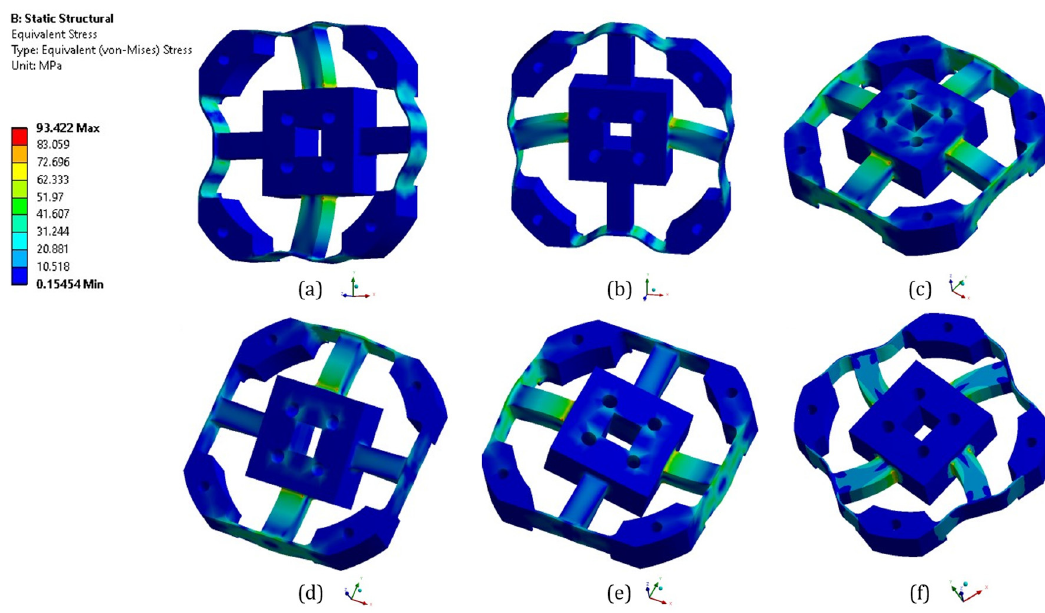
Figure 6. Equivalent stress from finite element analysis from different pure loading ( a ) F X = 500 N, ( b ) F Y = 500 N, ( c ) F Z = 500 N, ( d ) M X = 20 Nm, ( e ) M Y = 20 Nm, and ( f ) M Z = 20 Nm.